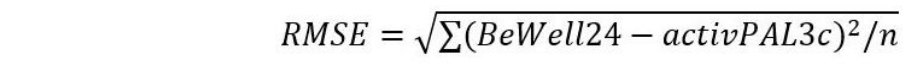
Figure 2. Root mean square error